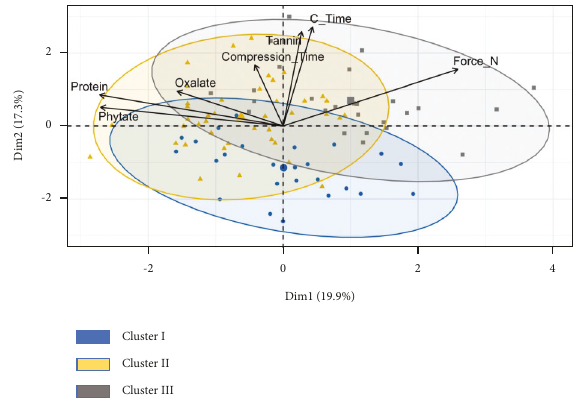
Figure 4: Principal component (PC) biplot showing the contri- bution of each trait to the variation observed in the studied African yam bean accessions. Force_N; compression force, CT_mins; cooking time, clus; cluster. The biplot was created using R software version